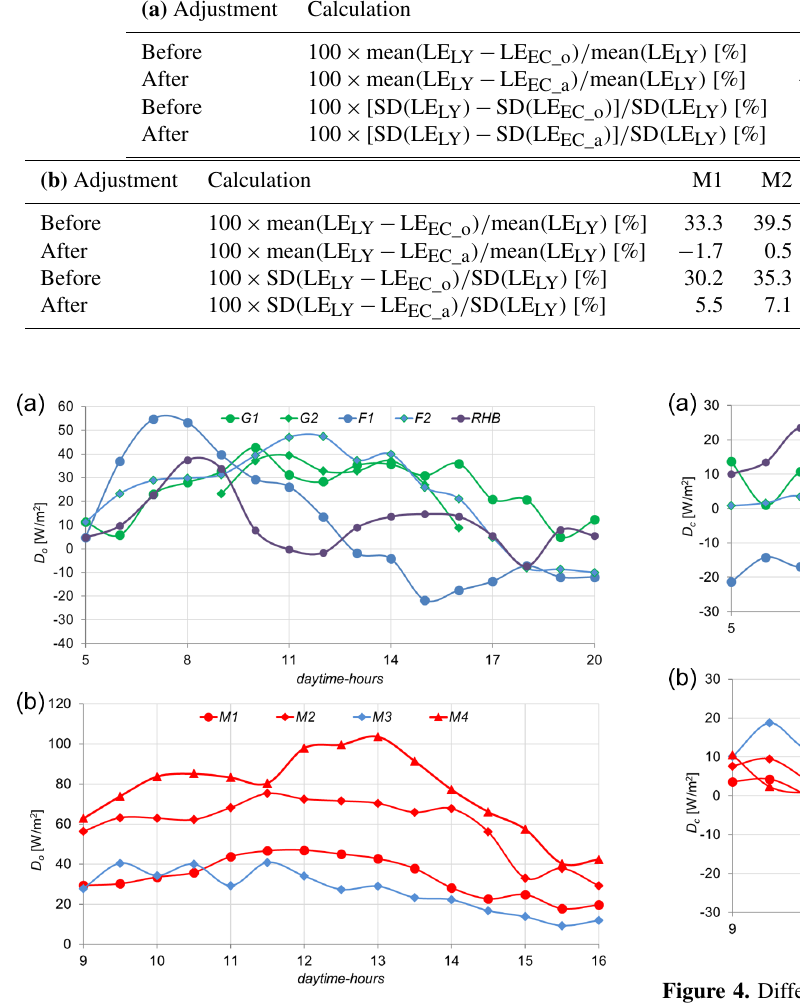
Figure 3. Differences D o = LE LY − LE EC_o : (a) as a function of daytime hours, humid; and (b) as a function of daytime hours, Ma- jadas; red: dry; blue: rainy season. less in humid climate with around 10 to 30 Wm − 2 (0.35 to